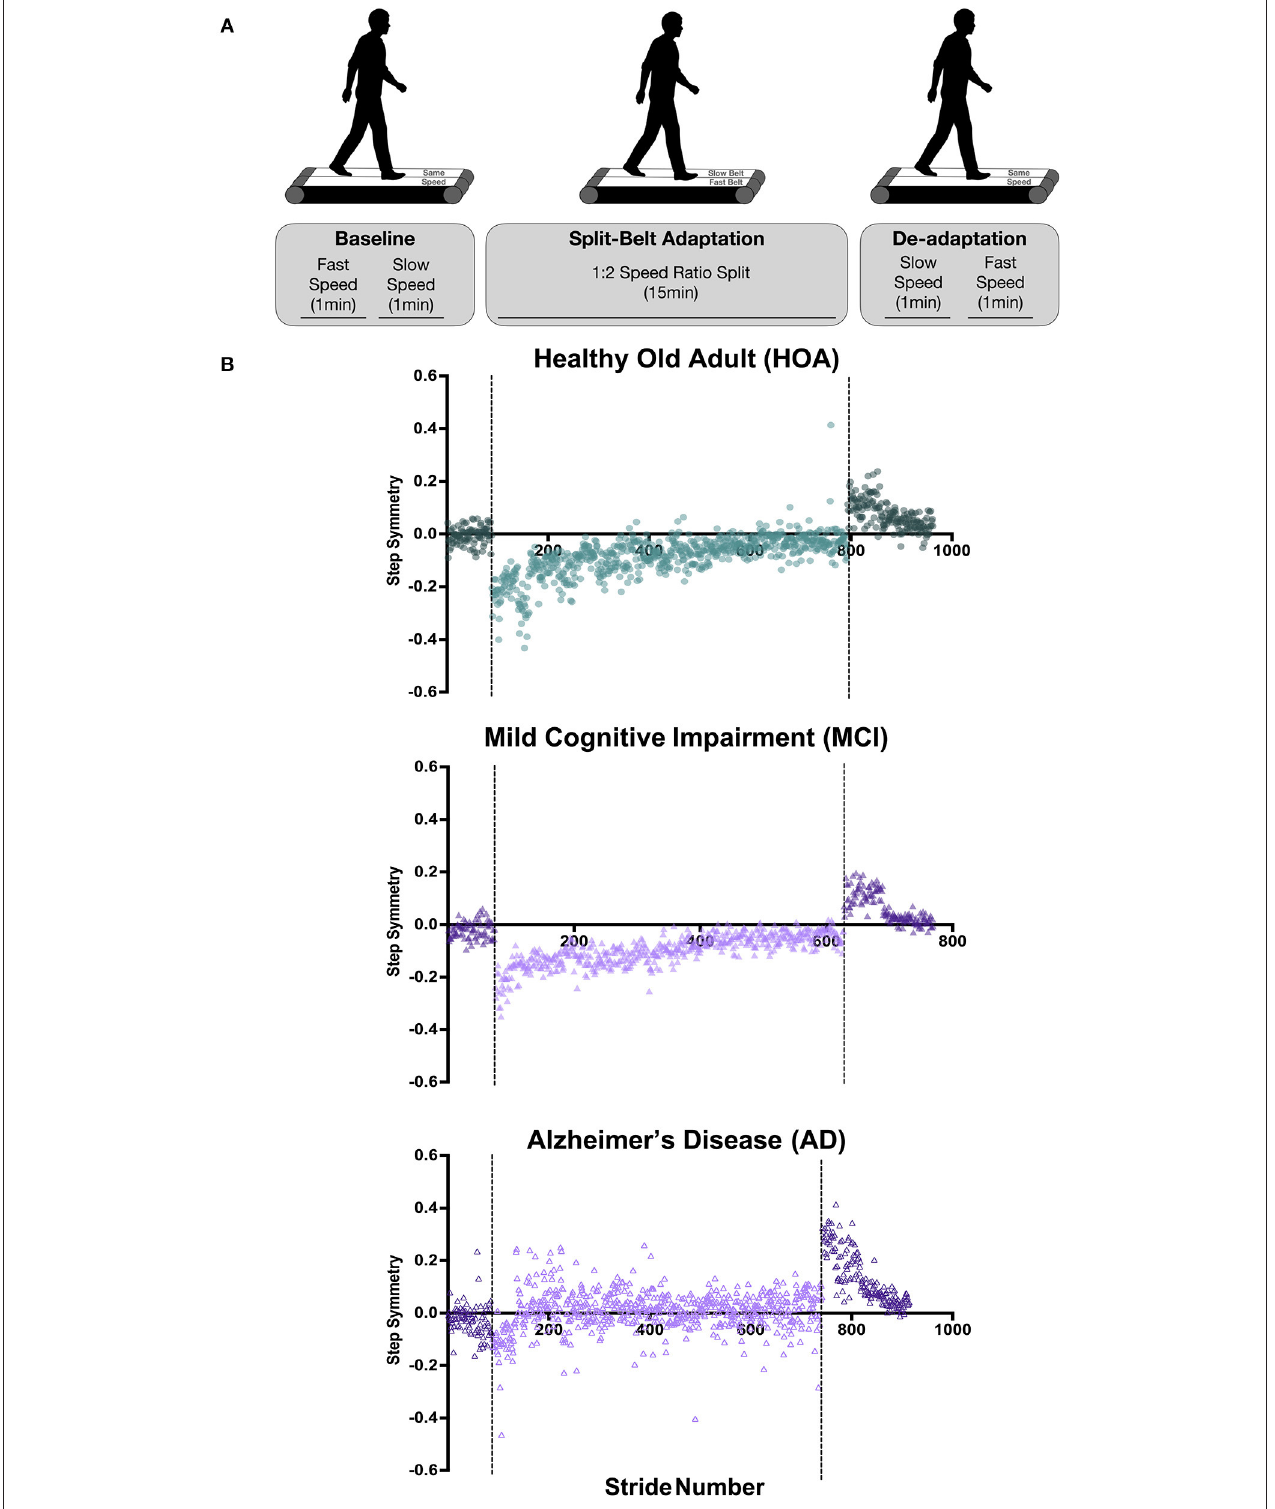
FIGURE 1 | Split-belt walking adaptation protocol and individual participant step symmetry data. (A) During baseline (tied-belt) walking, participants walked at their self-selected “fast” speed for 1min followed by 1-min walking at 50% of the self-selected speed, deemed the “slow” speed. During the split-belt adaptation period, the treadmill belt under the participant’s dominant leg was set to the fast speed, whereas the non-dominant leg was set to slow speed for 15min. The de-adaptation